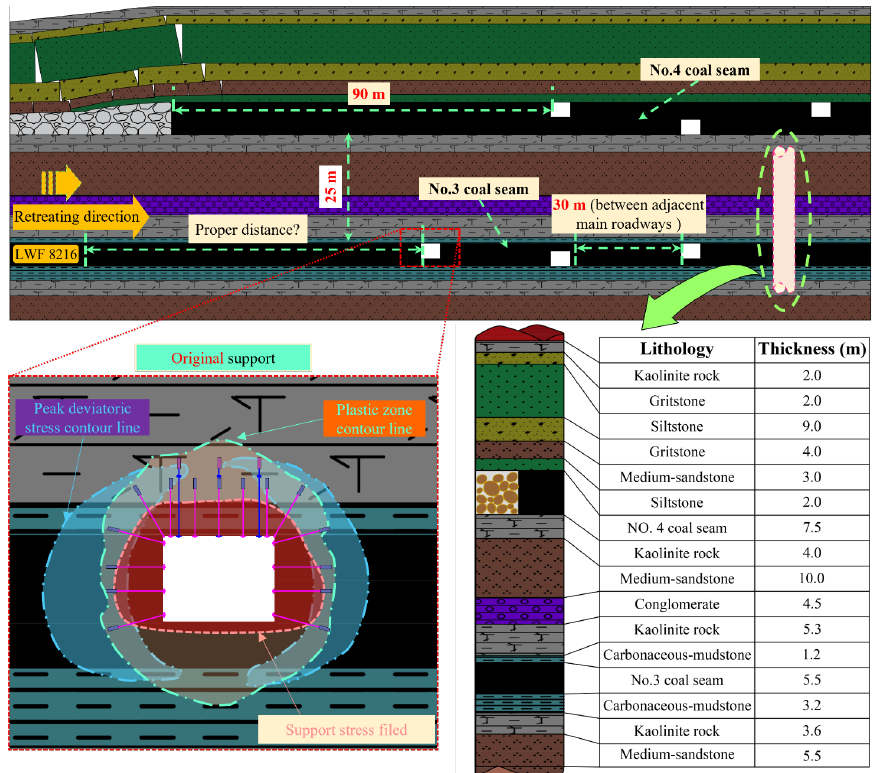
Figure 1. Main roadway group layout of the multiple coal seam and generalized stratigraphic column in the test site.